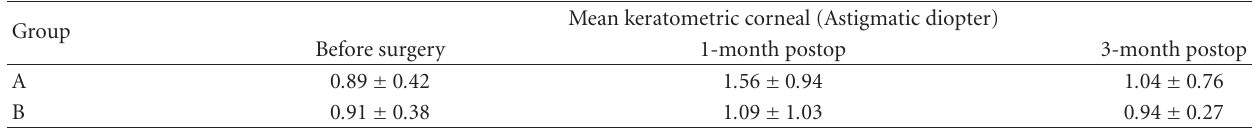
Table 1: Intergroup and intragroup comparison of mean keratometric cornea astigmatic diopter between Group A and Group B before and after